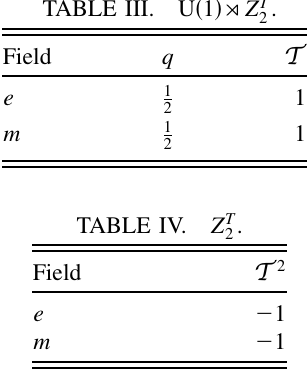
TABLE III. U ð 1 Þ 2 Z T